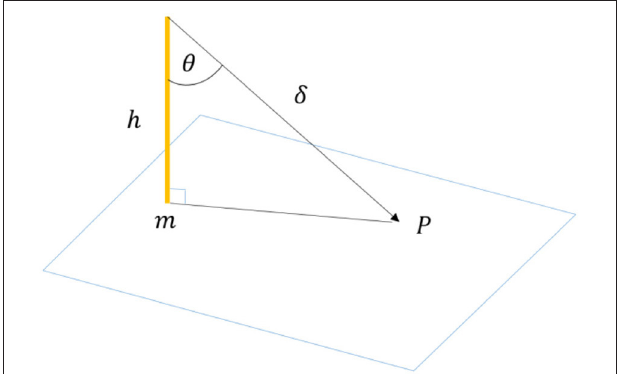
FIGURE 3 | Inverse square law for calculating illuminance.